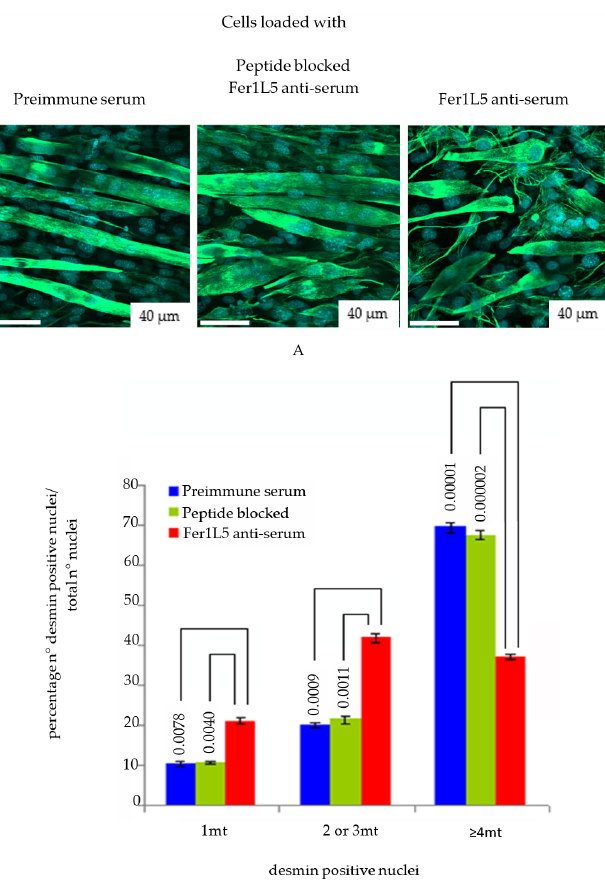
Figure 5. Fer1L5 inhibition impairs the formation of large myotubes. ( A ) D9 myotubes were used for fusion index. Desmin positive cells were counted in the antibody loaded myoblasts and myotubes in the 40 randomly chosen areas on the coverslips. Three independent experiments were performed in total and we counted 2792 nuclei for preimmune serum loaded cells, 2787 for Fer1L5 antiserum loaded cells and 2784 for peptide blocked Fer1L5 antiserum loaded cells. Desmin positive nuclei were identified using DAPI staining. ( B ) Histogram showing the fusion index and the p -values of the above three